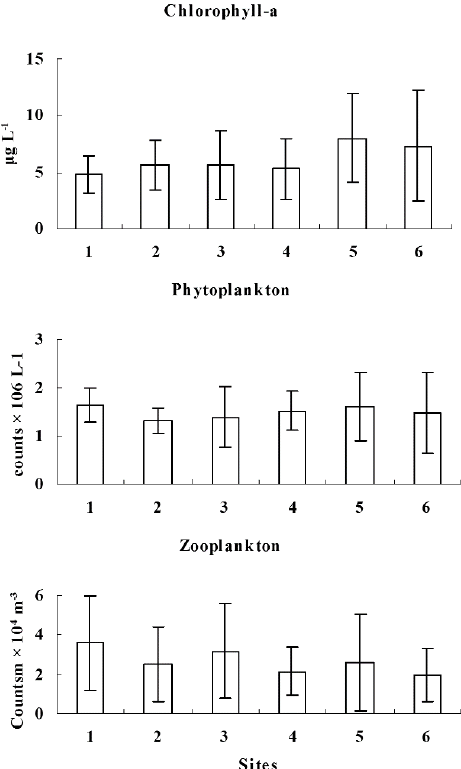
Figure 3. Spatial distribution of plankton (mean annual values ±SD) along the main stream of the Nile in Upper Egypt during 2007.